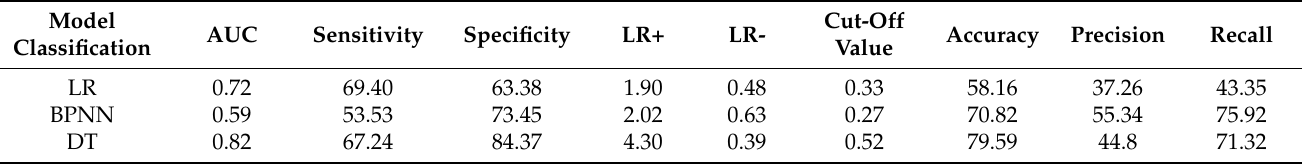
Table 3. Results of verification accuracy and fit superiority of LR, BPNN, and DT models for all variables across Northeastern China in 2021.